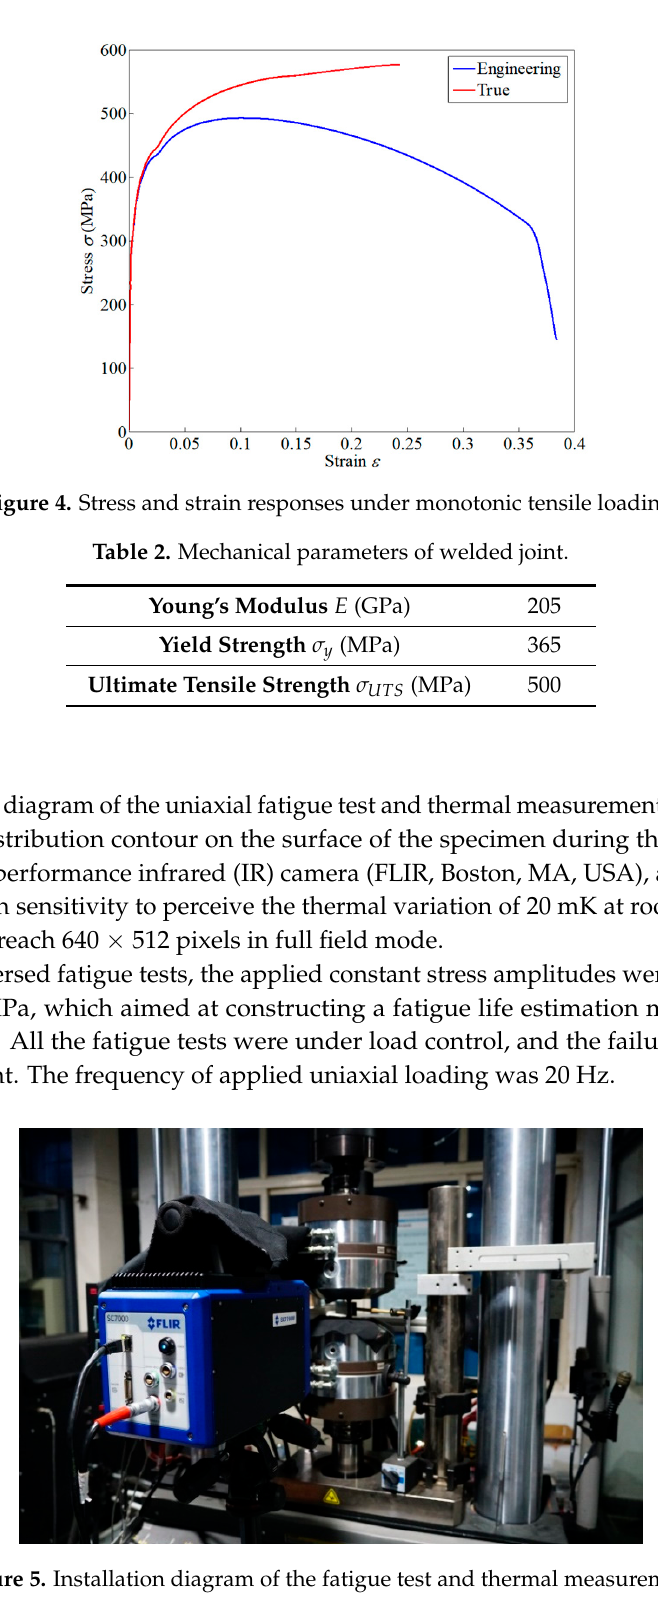
Figure 6. Temperature distribution contour measured by IR camera (unit: °C). 2.4. Thermal Evolution The heat caused by the internal friction between microstructures under cyclic loading is dissipated through weld metal. The temperature increment θ with respect to initial temperature could be obtained from the thermal-graphic measurement. The thermal evolution in whole life cycles under stress amplitudes 300 MPa and 260 MPa are shown in Figure 7 and Figure 8, respectively. Before the temperature increment comes into the stable stage II, as shown in Figure 7, the temperature of the material surface increases continuously, due to cyclic straining, until a relative equilibrium state between the internal heat production and external heat exchange is reached [19 – 23]. Being different from pure metal materials, the temperature increment of this welded joint linearly increases during the stable stage II both in high stress amplitude and low stress amplitude. Thus, the method for calculating accumulated intrinsic dissipation and predicting lifespan has to be developed.